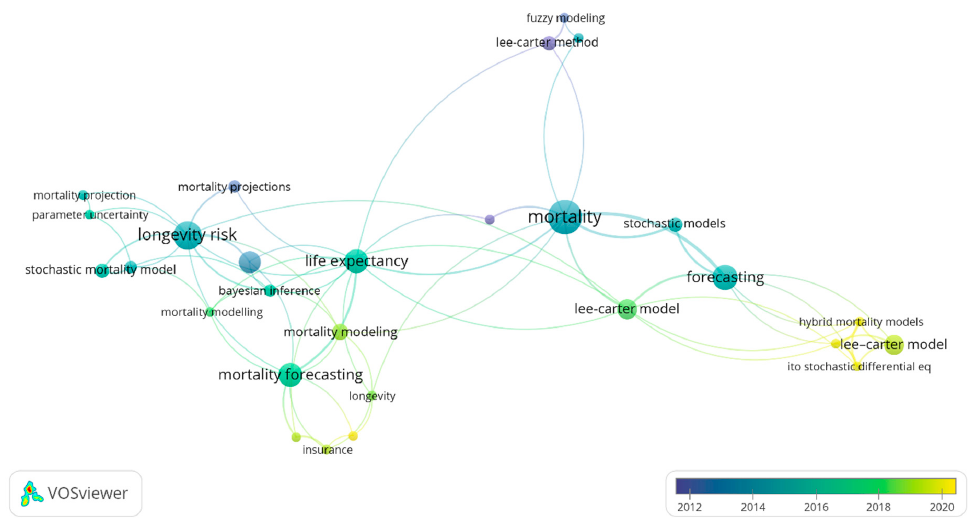
Figure 5. Co ‐ occurrences of keywords. Figure 5. Co-occurrences of keywords.